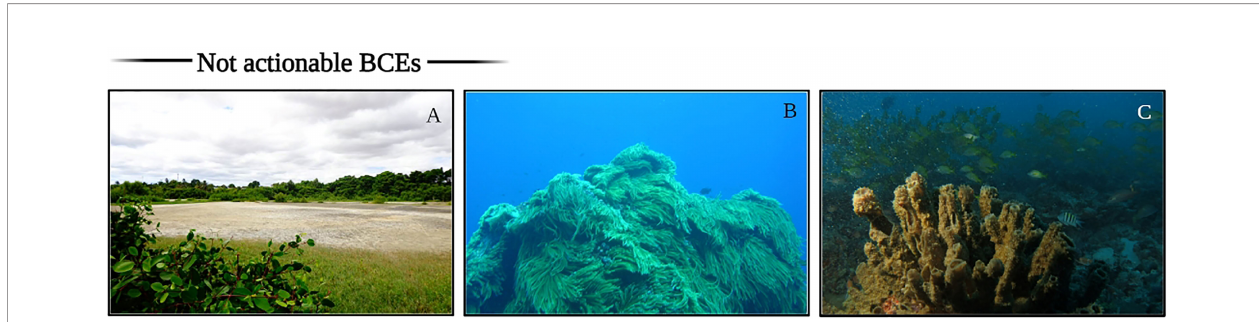
FIGURE 3 | The Blue Amazon (Brazilian Economic Exclusive Zone, South Atlantic) contains potential and non-actionable BC ecosystems that could contain vast amounts of stored carbon. (A) Hypersaline tidal fl at (E.g., Barra do Ceara-Ceara state. Photo: N. Beloto, 2020) (B) Macroalgal beds (E.g., Arquipelago de S.Pedro e S.Paulo-Pernambuco state. Photo:Dimas Gianuca, 2004); (C) Marine animal forest (E.g., Parque Estadual Marinho da Pedra da Risca do Meio - Ceara state. Photo: Marcus Davis,